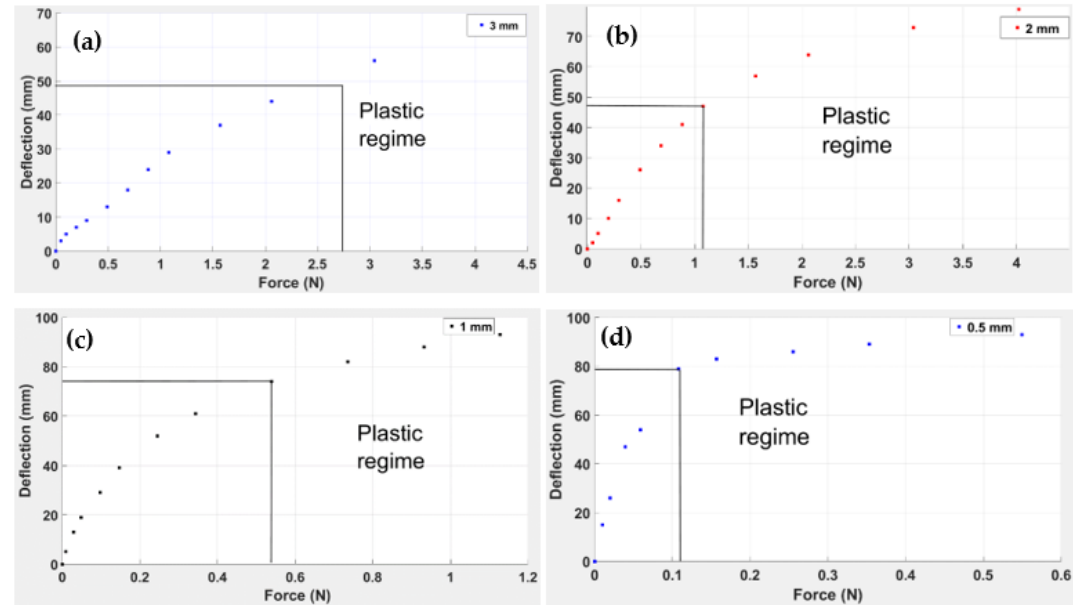
Figure 10. Deflection of end loaded simple ABS beam 145 mm long,10 mm wide and thicknesses: ( a ) 3 mm, ( b ) 2 mm, ( c ) 1 mm and ( d ) 0.5 mm.